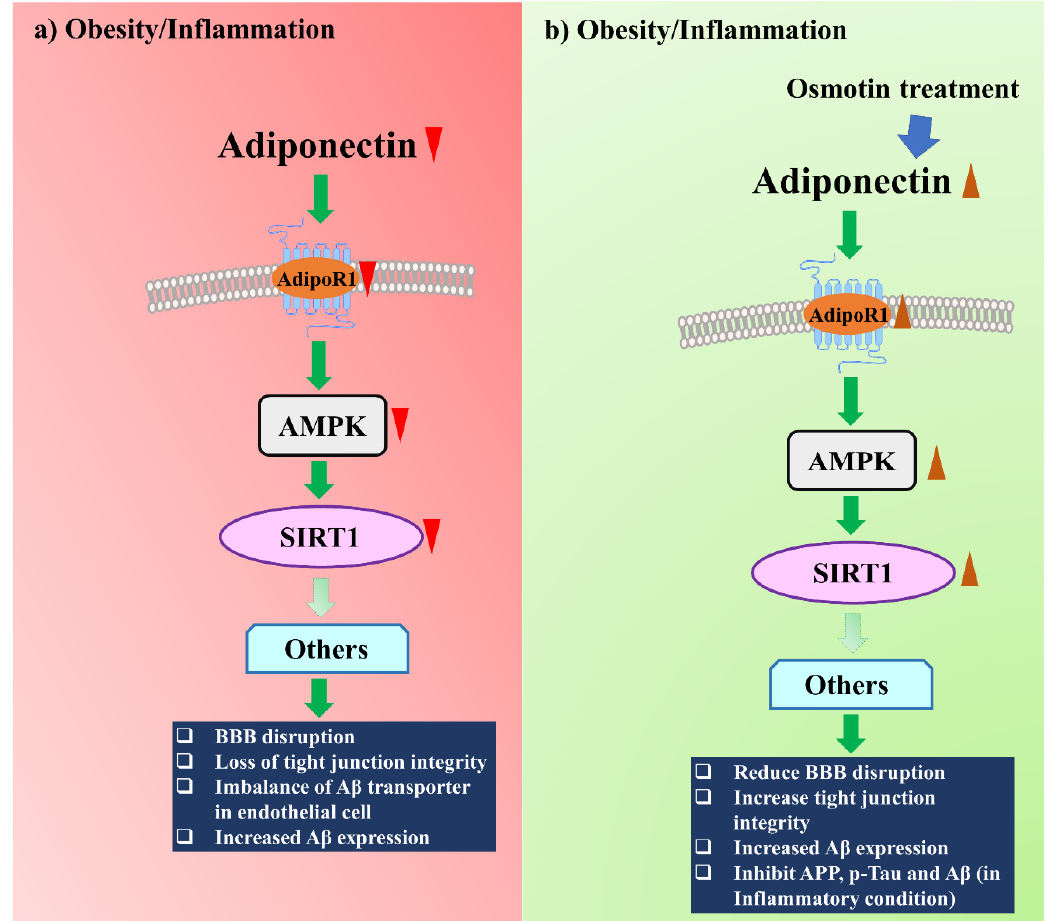
Figure 3. Osmotin treatment positively modulates AD through the AdipoR1 / AMPK / SIRT1 pathway. ( a ) Obesity reduces adiponectin and AdipoR1 expressions, which negatively modulate the AMPK / SIRT1 pathway and increase the AD biomarkers. ( b ) Osmotin treatment increases adiponectin and AdipoR1 expressions and reduces AD biomarkers through the AMPK / SIRT1 pathway.